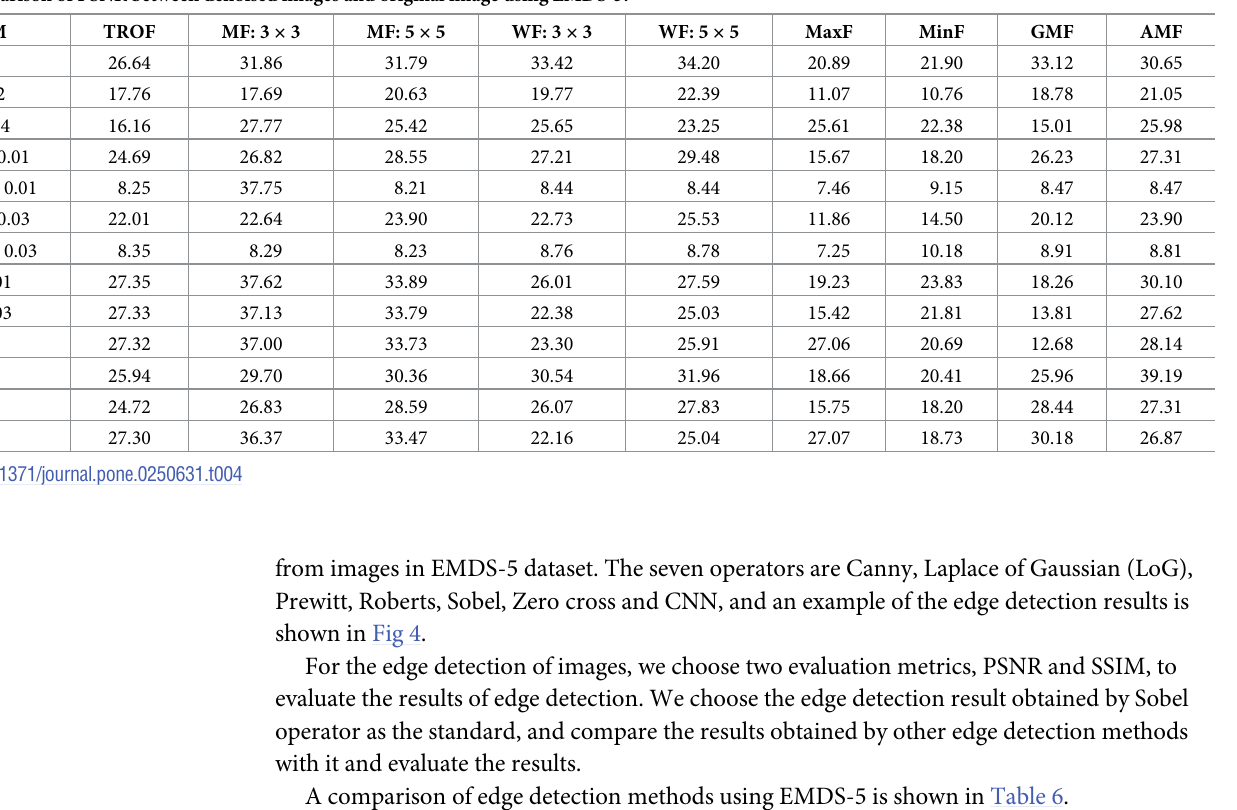
Table 4. A comparison of PSNR between denoised images and original image using EMDS-5. ToN / DM TROF